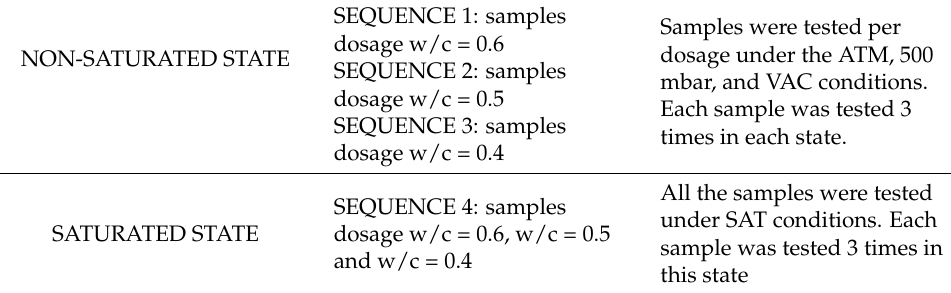
Table 3. Study phases.